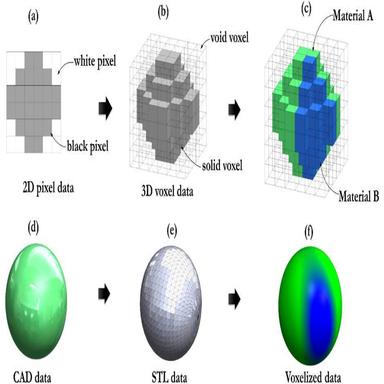
Voxel-based workflow representing FGM objects, (a) 2D pixel image; (b) 3D voxel model; (c) defined materials for each voxel; (d) CAD model data; (e) STL data containing only geometrical information; (f) voxelated data generated from STL model, which contains two different material phases.